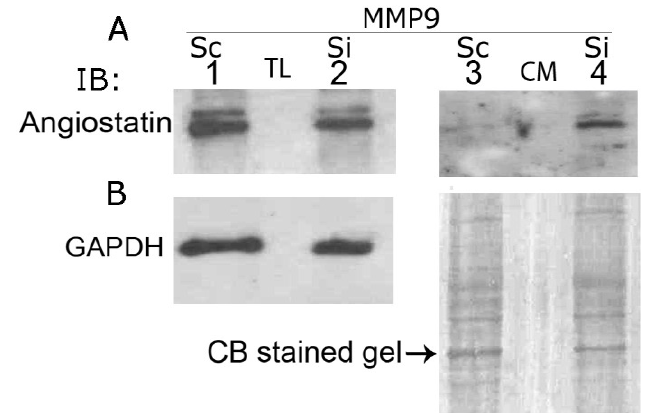
Figure 6. MMP9 knockdown increases secretion of angiostatin in PC3 cells. Total cellular lysates (TL; lanes 1 and 2) and conditioned media (CM; lanes 3 and 4) made from PC3/Sc (MMP9) (lanes 1 and 3) and PC3/Si (MMP9) (lanes 2 and 4) were immunoblotted with an antibody to angiostatin ( A ). Equal amount (20 µg) of protein was used for immunoblotting analysis. Membrane was stripped and reprobed with a GAPDH antibody ( B , left). GAPDH level was used as a control for loading. Equal protein loading in conditioned media was verified by Coomassie blue ( B , right) staining of a gel ran in